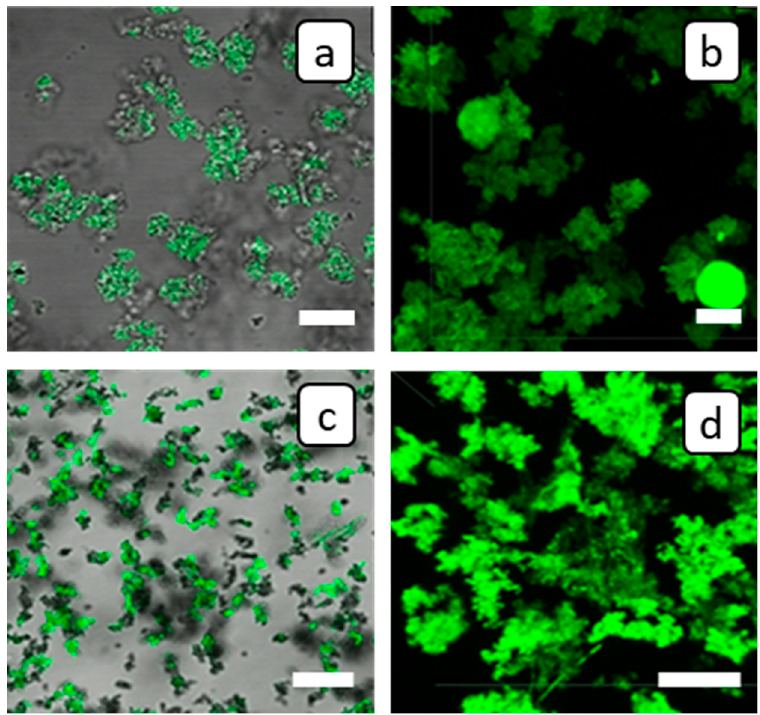
Figure 4. LSM 2D ( a , c ) and 3D ( b , d ) images of solids deposited after 20-fold evaporation of 20 mg·dm − 3 CaCl 2 aqueous solution at 70 °C in presence of 10 mg·dm − 3 HEDP-F ( a , b ) and ADMP-F 20 mg · dm − 3 CaCl 2 aqueous solution at 70 ◦ C in presence of 10 mg · dm − 3 HEDP-F ( a , b ) and ADMP-F ( c , d ). Scale bar 20 µm . ( c , d ). Scale bar 20 µ